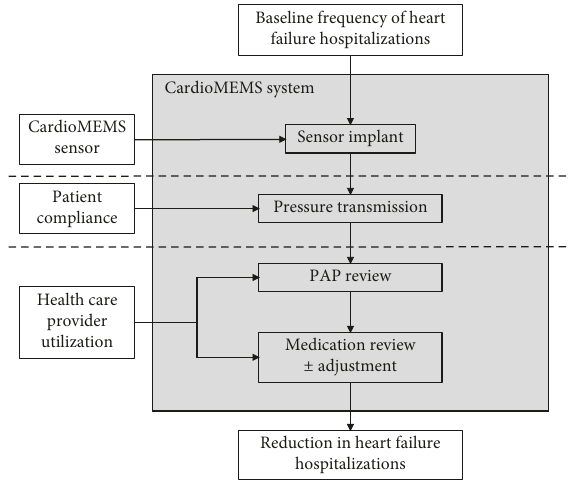
Figure 1: The CardioMEMS system. It requires multiple inputs to achieve its aim of reducing heart failure hospitalizations. The sensor must be implanted correctly and safely, patients must transmit pulmonary artery pressure (PAP) data regularly, and health care providers must review those data and formulate treatment plans. Patients can transmit their PAP data at home or in other non- hospitalized settings, and health care providers review data in an independent process at a separate time